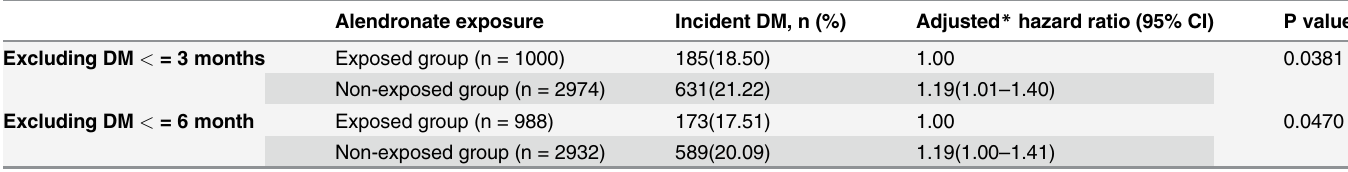
Table 4. Sensitivity analysis of Hazard ratio for incident DM in both groups after excluding new DM cases within 3 or 6 months after enrollments. Alendronate